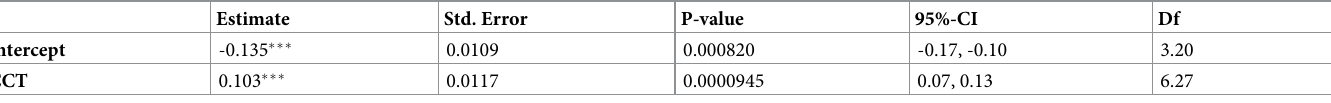
Table 3. RVE meta-regression results.